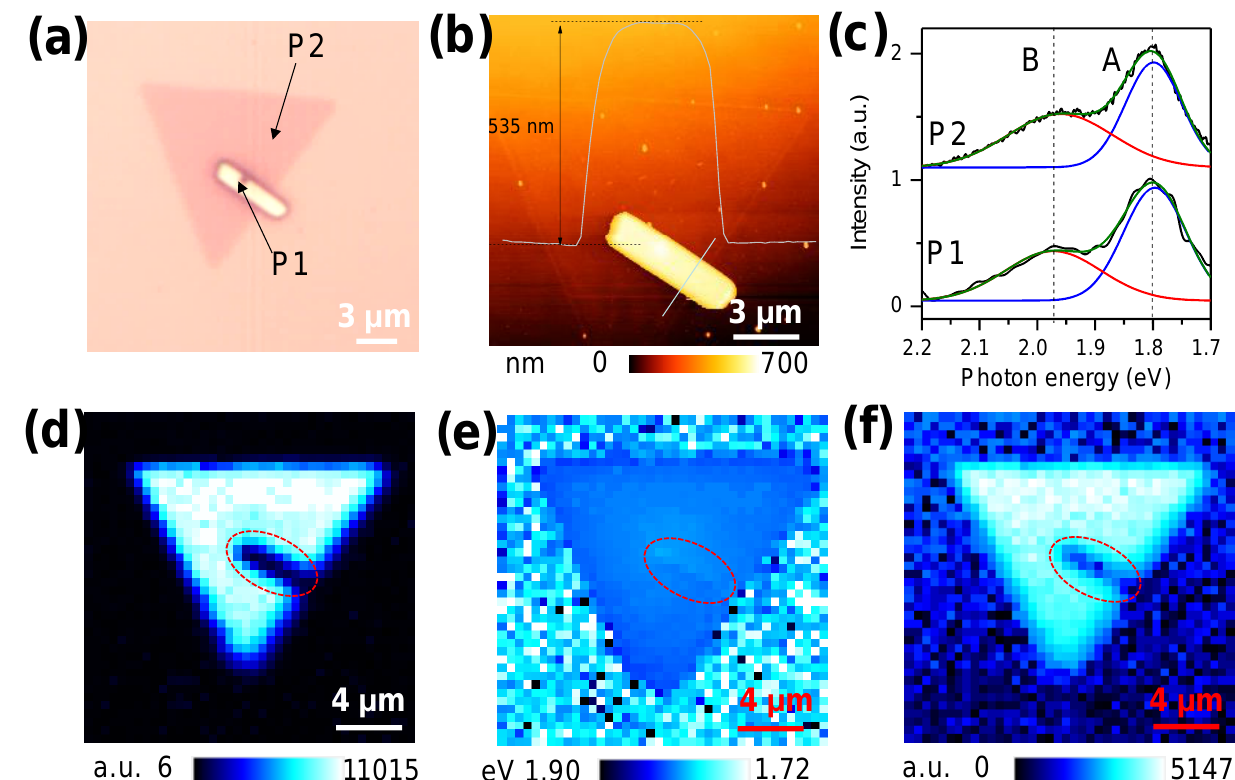
Figure 3. ( a ) Optical and ( b ) AFM topography images of a Sb 2 Se 3 /MoS 2 HJ on SiO 2 /Si substrate; a height profile collected along the marked line in ( b ) is plotted as an inset. ( c ) PL spectra collected on the HJ (P1) and 1L-MoS 2 (P2) areas marked in ( a ); in ( c ), fitting using B and A excitons gives very good fitting results. ( d ) PL intensity of A exciton. ( e ) PL peak position of A exciton and ( f ) Raman A ′ peak intensity of the sample in ( a ). In ( d – f ), laser: 532 nm, laser power: 34 μW , exposure time: 1 s, 40 × 40 pixels.